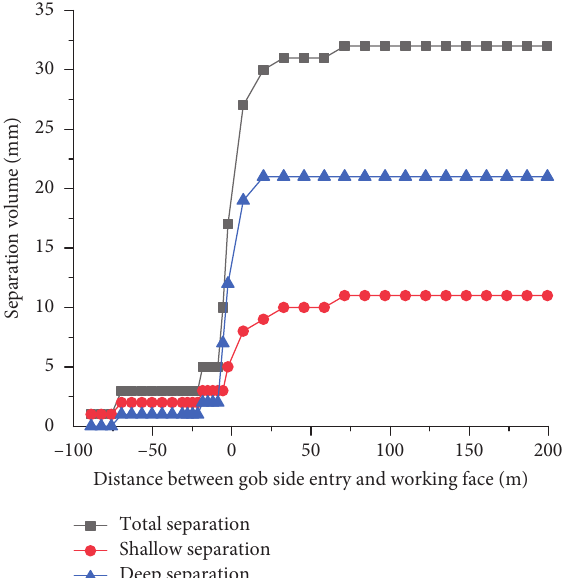
Figure 12: The roof separation instrument records the roof separation change curve at 200 mm of the return air